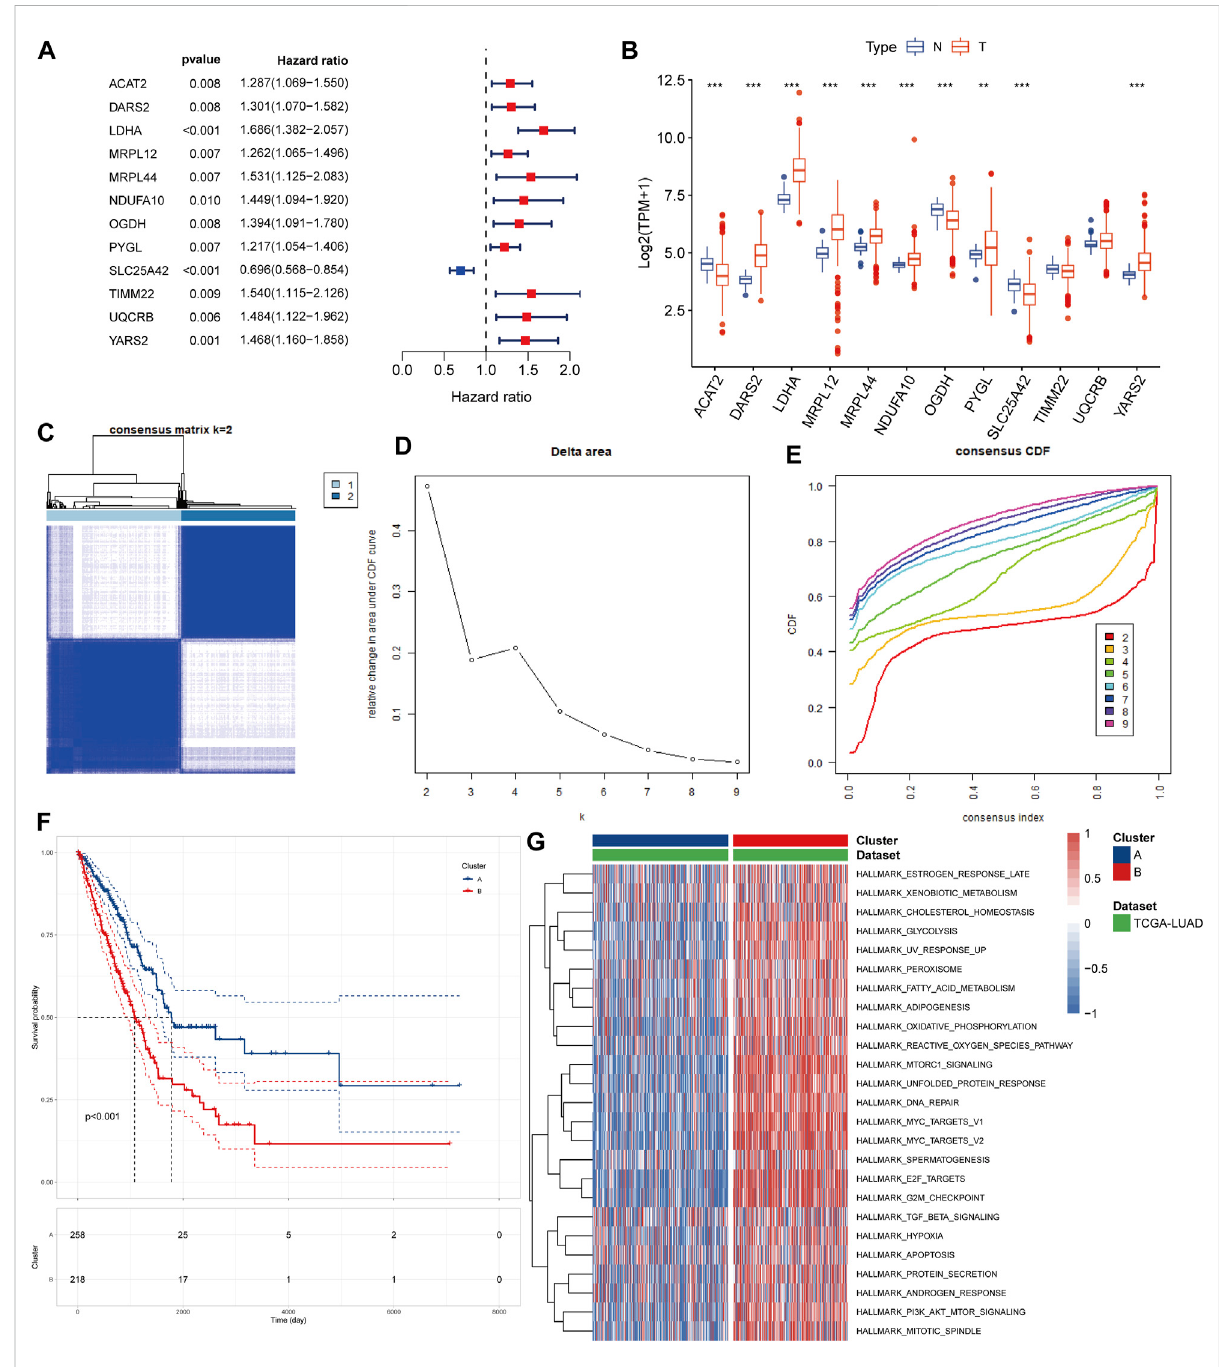
FIGURE 2 Identi fi cation of lactate-related subtypes of LUAD (A) Screening of prognostic lactate-related genes by univariate cox analysis (B) Comparison ofexpressionvaluesoflactate-relatedprognosticgenesbetweennormalsamplesandtumorsamples (C) Consensusmatrixheatmapwhenk=2 (D) Delta area plot showed the relative change in area under CDF curve as the value of k changes (E) CDF plot showed the cumulative distribution function for different values of k (F) K-M survival curves showed that LSA patients have better prognosis than LSB patients (G) Different ssGSEA analysis results of two isoforms on hallmark gene sets, different colors represent the different ssGSEA